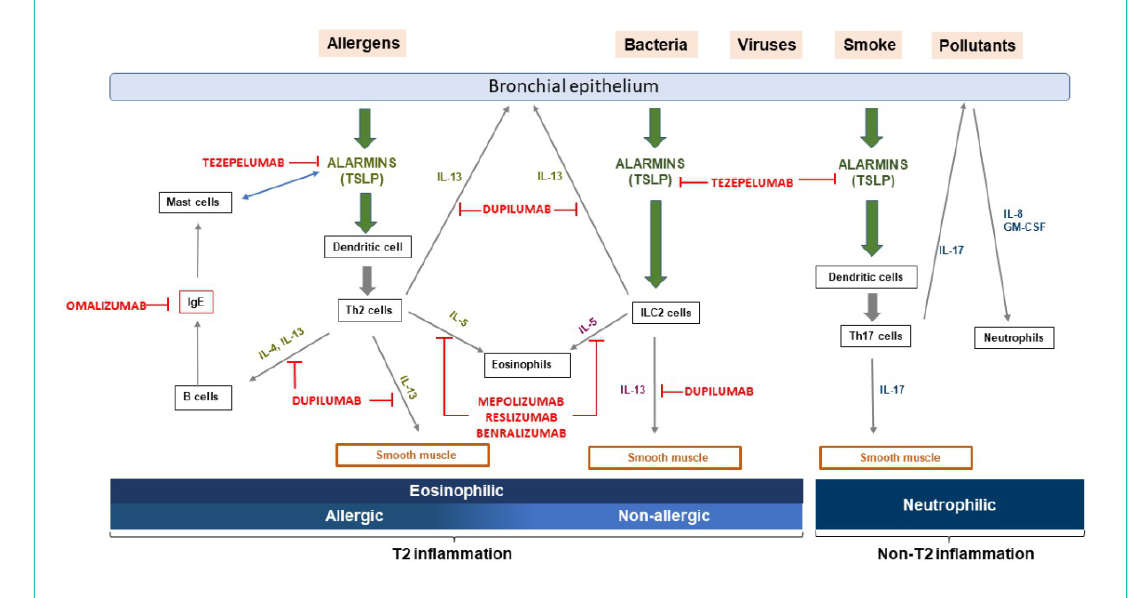
Figure 1: Pathophysiological mechanisms of T2-high asthma. T-helper cells type 2 (Th2) and group 2 innate lymphoid cells (ILC2) when stim- ulated by alarmins (IL-25, IL-33, TSLP) released by bronchial epithelial cells in response to stressors, produce T2 inflammatory cytokines such as IL-4, IL-5 and IL-13, leading to IgE switching in B cells, degranulation of mast cells, airway eosinophilia, mucus hypersecretion from goblet cells, and smooth muscle contraction resulting in airway hyper-responsiveness. Alarmins can also directly induce mast cells to produce T2